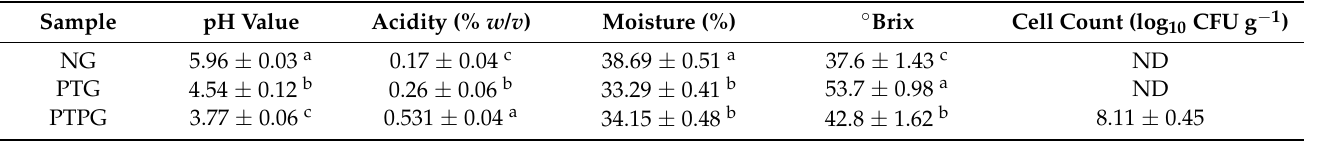
Table 5. Chemical variables analyses and cell counts for the unfermented and fermented glutinous rice